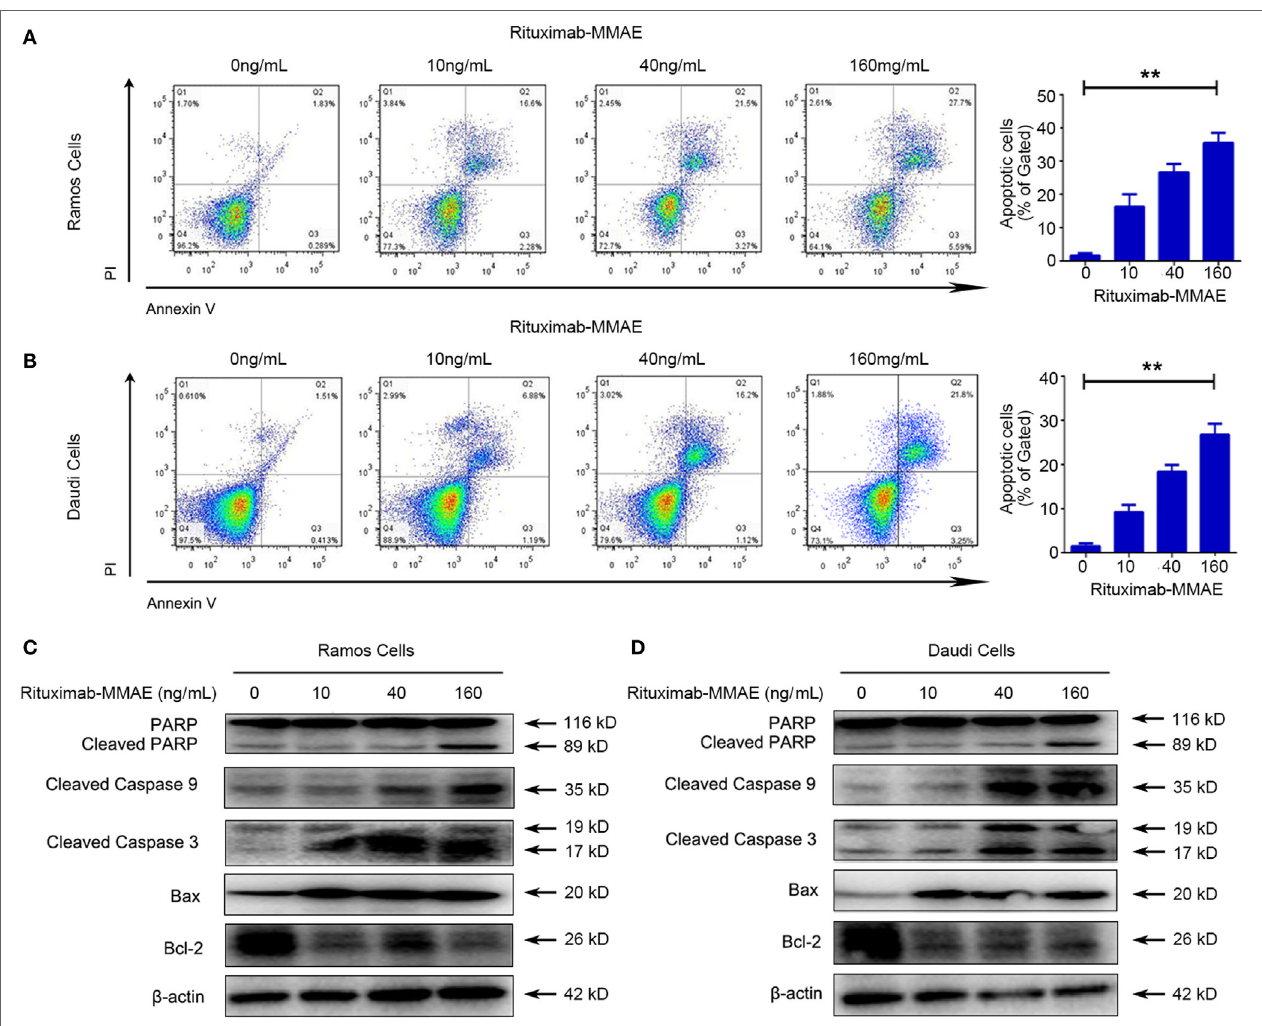
FigUre 2 | Rituximab-monomethyl auristatin E (MMAE) induced apoptosis in non-Hodgkin lymphoma cells. Apoptosis induced by Rituximab-MMAE was detected by western blot and flow cytometry (FCM). Ramos and Daudi cells were incubated in different concentration of Rituximab-MMAE. (a,B) Apoptosis was detected by FCM. The percentage of Annexin V + PI − and Annexin V + PI + cells (apoptosis cells) was shown in right bar chart. (c,D) The protein level of poly ADP-ribose polymerase (PARP), cleaved PARP, cleaved caspase 9, cleaved caspase 3, Bax, and Bcl-2 was detected by western blot; β -actin was used as a loading control. Densitometric values were quantified by Image J